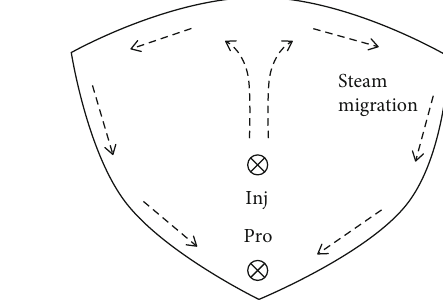
Figure 1: SAGD production mechanism diagram for double horizontal